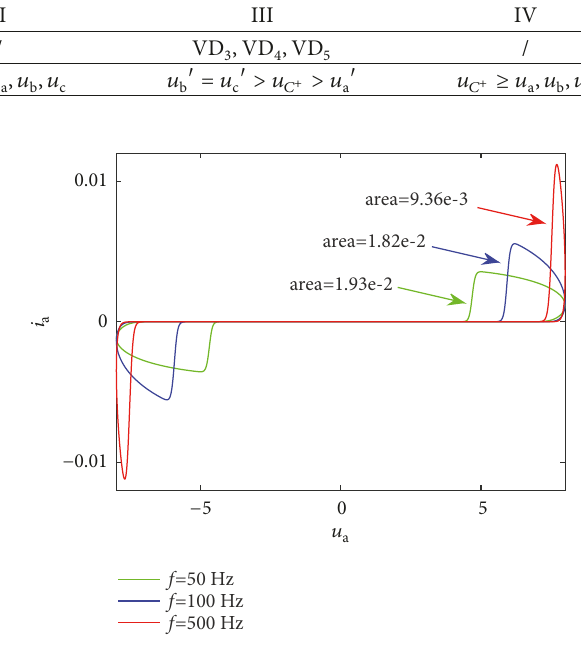
Figure 16: Curves of input voltage 𝑢 a and input current 𝑖 a .